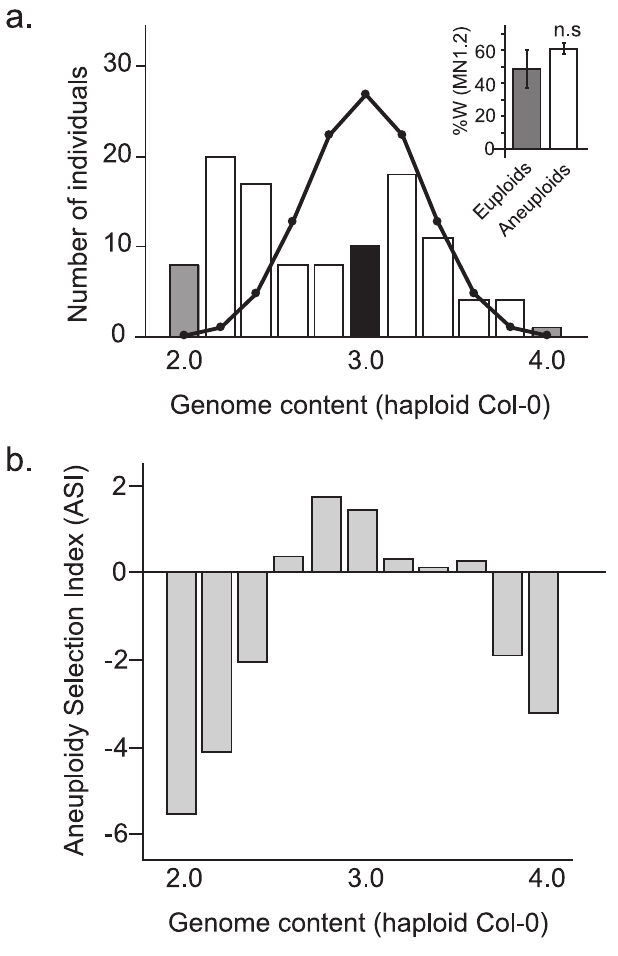
Figure 3. Calculation of the ASI for Each Genome Content Class in the CWW F 2 Population Genome content is expressed as multiples of the nuclear genome content of haploid Col-0. (A) The number of individuals in each genome content class observed in the CWW F 2 population (bars) was compared to the expected numbers based on random assortment of chromosomes at meiosis and absence of selection (line). Euploid classes (diploids and tetraploids) are represented by gray bars, while aneuploid classes are represented by white bars. Inset: the mean percentage of Wa-1 allele at MN1.2 was higher in the aneuploid than in the euploid individuals but the difference was not significant (t-test p -value ¼ 0.382). Individuals with a genome content of 3.0 (black bars) were excluded from this analysis, because it was not possible to determine their exact karyotype and whether they were true triploids or aneuploids with a genome content consistent with 15 chromosomes. (B) ASI values for each genome content class. Negative values indicate that a class is observed more often than expected, while positive values indicate that a class is observed less often than expected.